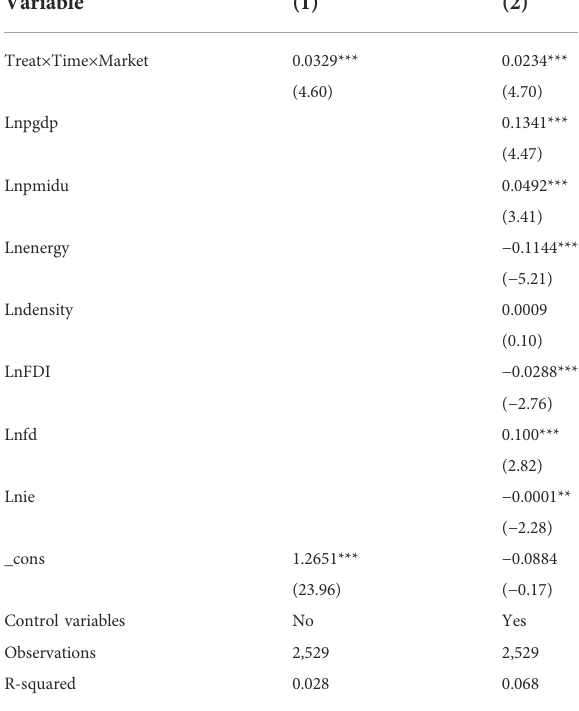
TABLE 11 Marketization degree adjustment effect